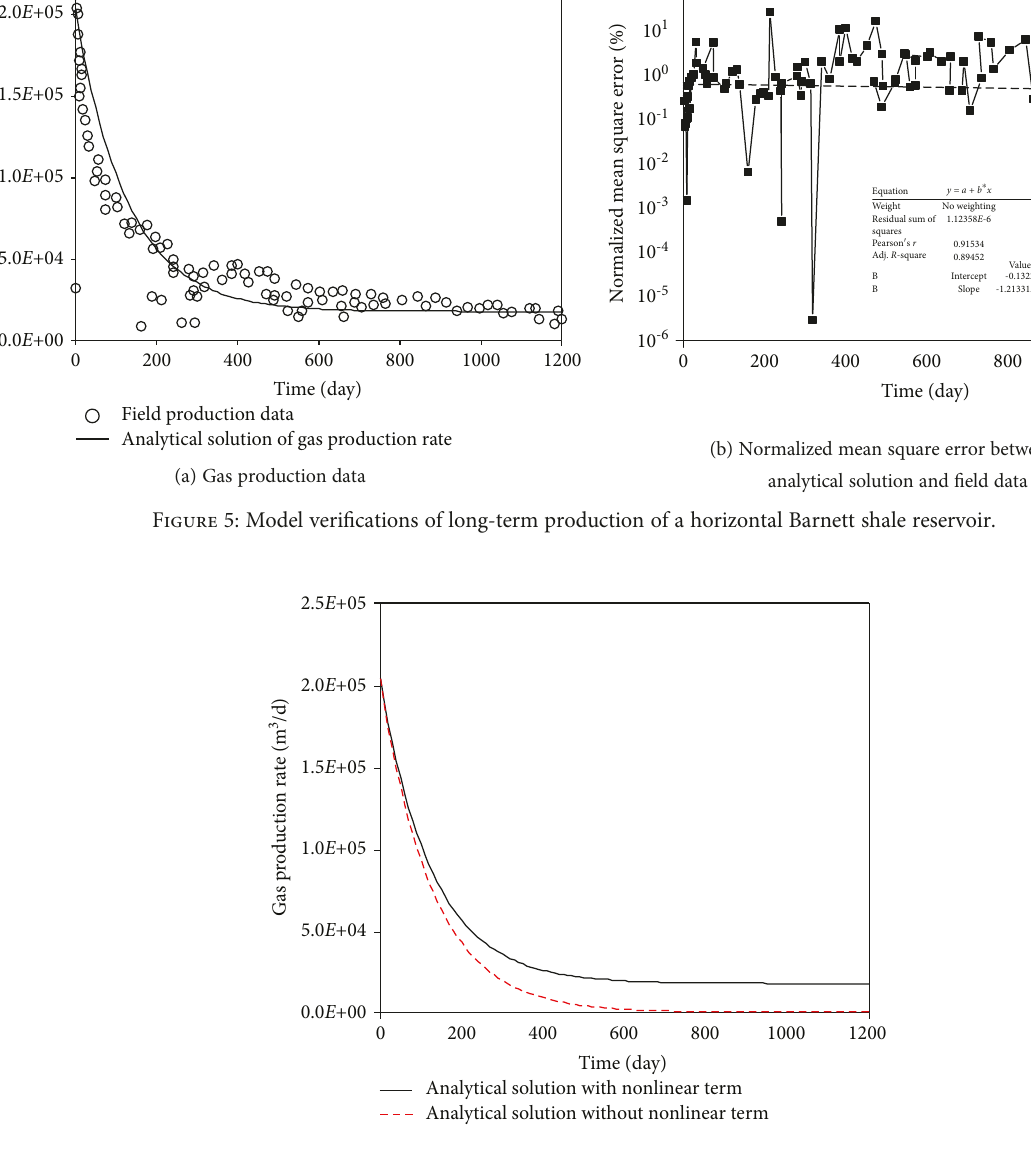
Figure 6: Impact of the nonlinear phase of the governing equations for the two-phase fl ow on the gas production